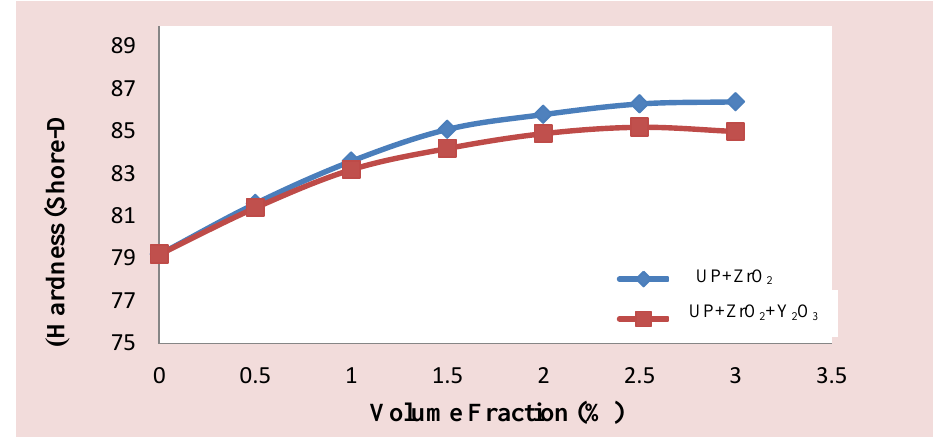
Fig .4: Hardness of the (UPE) nanocomposites as a function of the volume fraction of nanoparticles and hybrid nanoparticles content in the composite